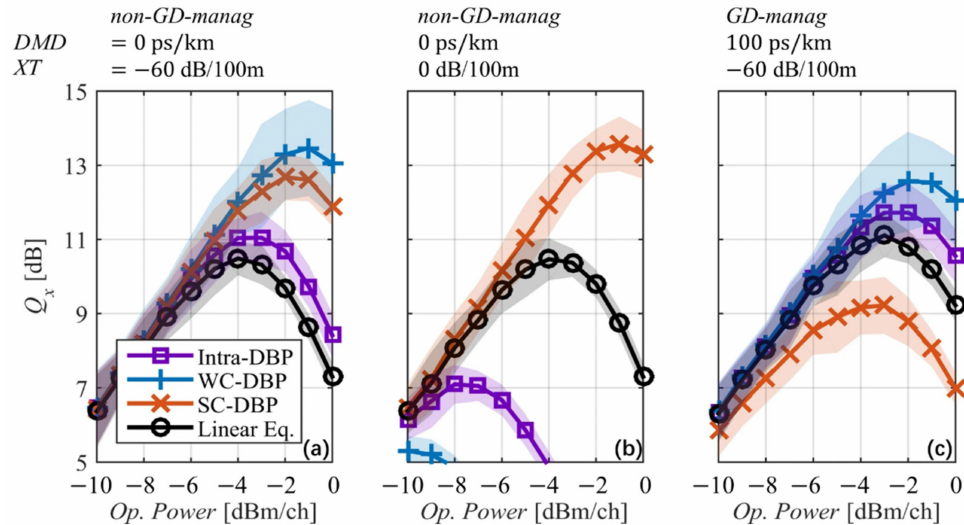
Figure 16. Q factor vs. launched power per channel in three different cases. ( a ) low XT and DMD free; ( b ) high XT and DMD free; ( c ) low XT and high DMD with GD-managed.